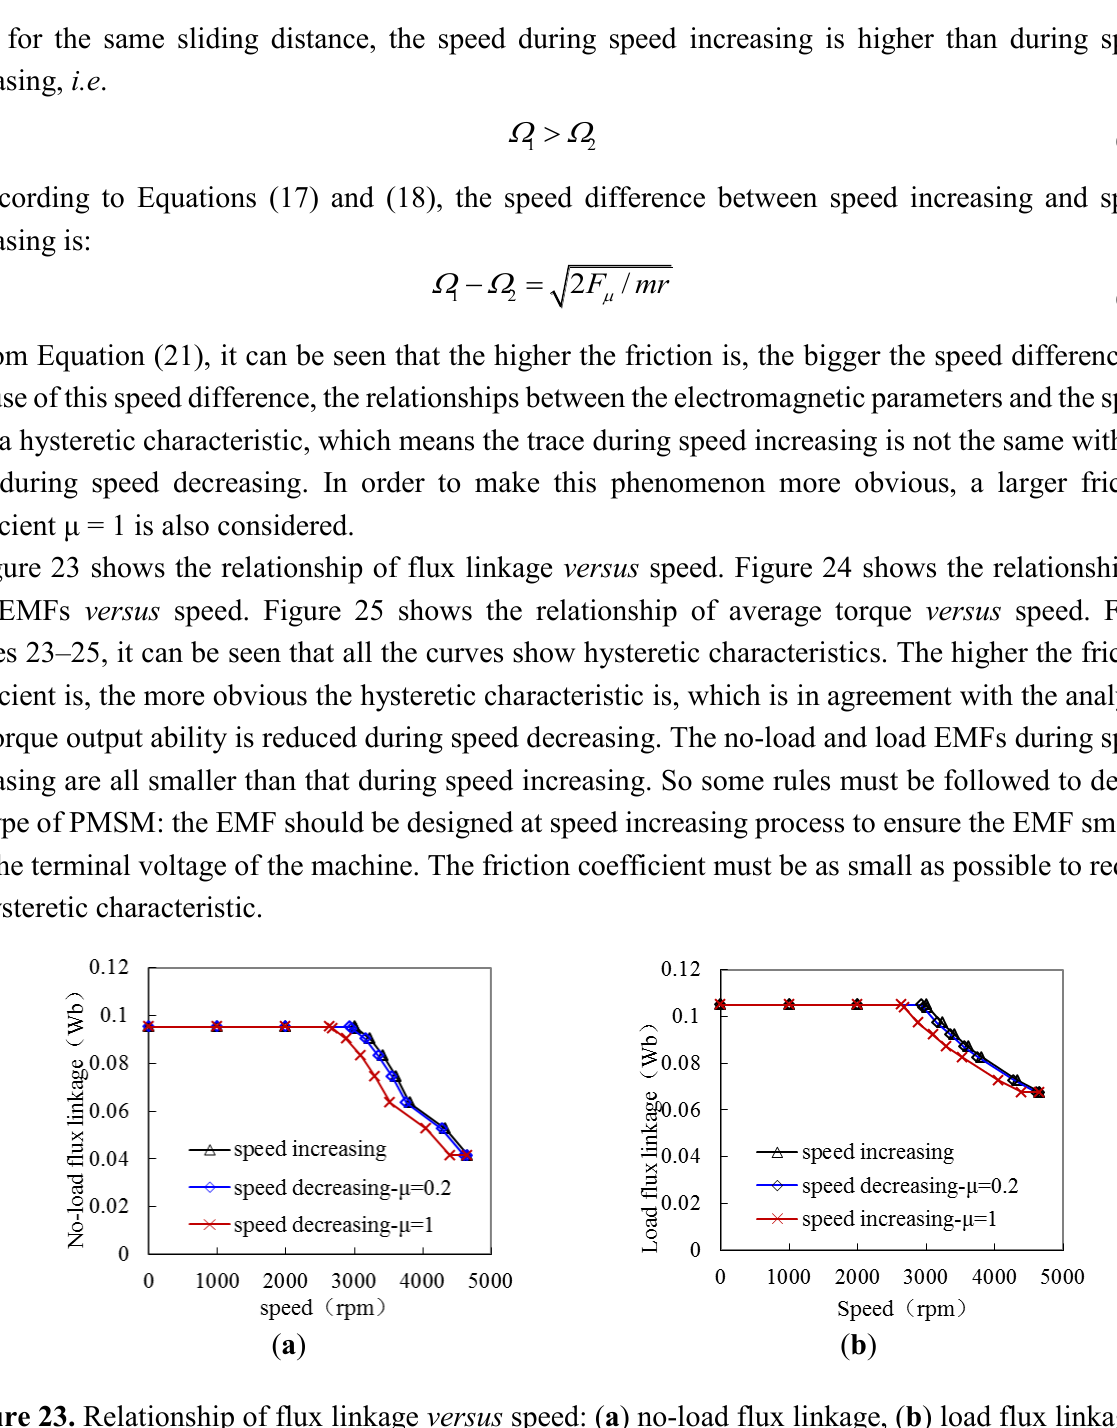
Figure 23. Relationship of flux linkage versus speed: ( a ) no-load flux linkage, ( b ) load flux